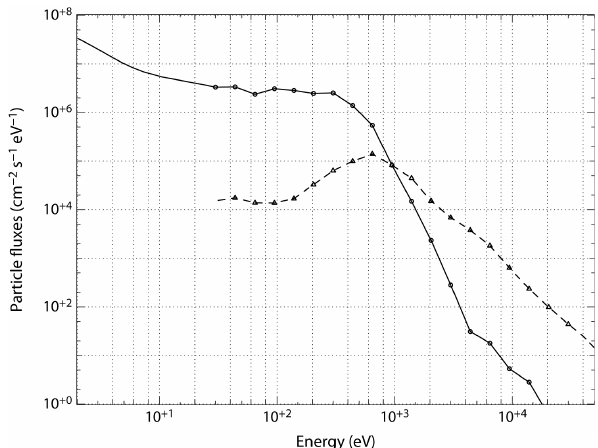
Fig. 2. Differential particle fluxes in units of cm − 2 s − 1 eV − 1 ver- sus energy (in keV) and averaged over 30s between 08:44:55 and 08:45:25 UT as measured by DMSP. Black circles represent the par- ticle electron flux distribution and black triangles the proton flux distribution. Though the proton fluxes at their peak are nearly 100 times less intense, their average energy is twice as high, i.e. 1keV vs. 400eV for the electrons. Each spectrum is extrapolated at high and low energies (solid and dashed lines for electrons and protons respectively), where they show a behaviour very different from a Maxwellian